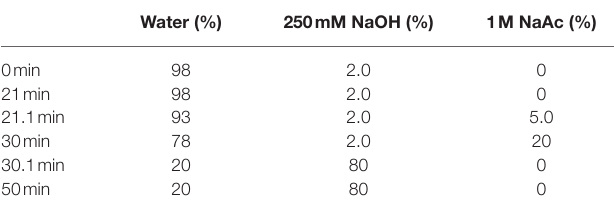
TABLE 1 | HPLC mobile phase